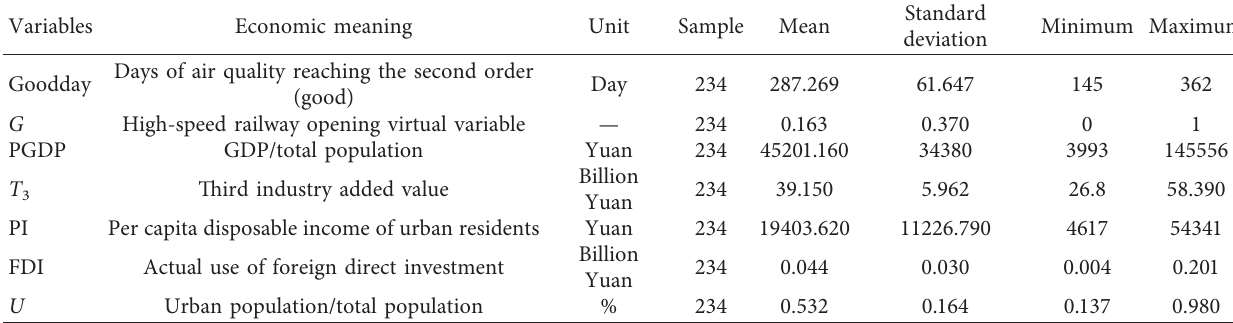
Table 1: Statistical description of major variables.